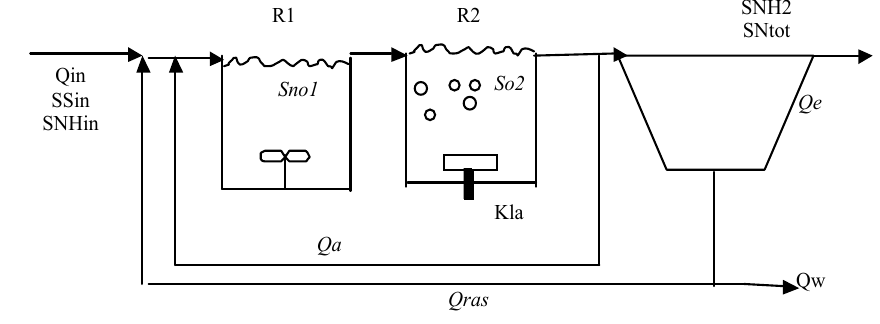
Figure 2. Schematic representation of the